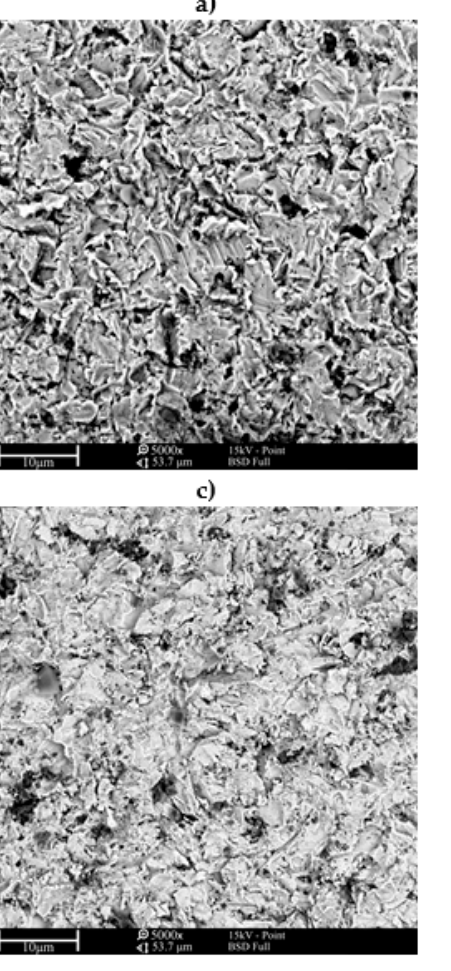
Figure 12. The SEM micrographs of worn surfaces after erosive tests with the impingement angle 90°; ( a , b ) representative surface layer; ( c , d ) reference material EN GJS 350-22.